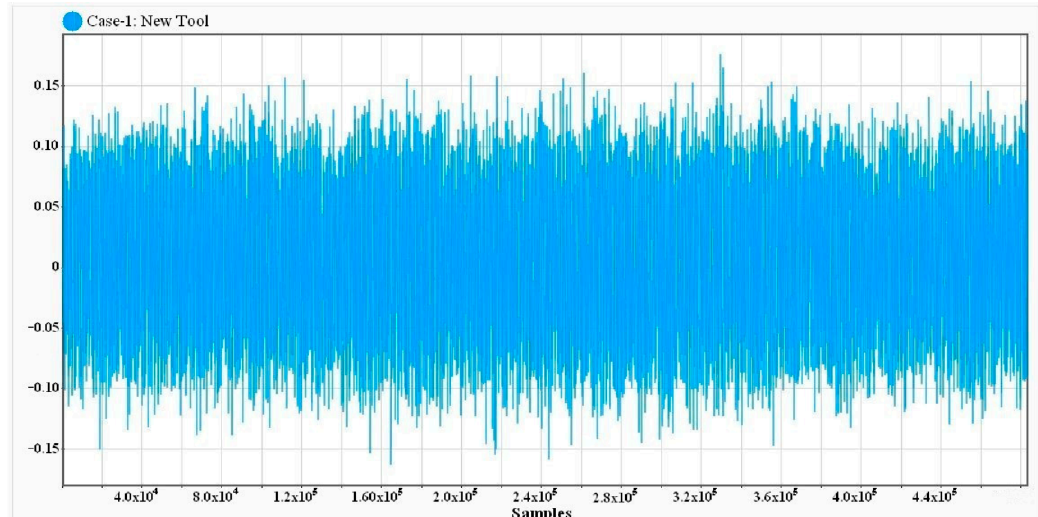
Figure 12. Plot of raw acoustic emission (AE) signal of 10 s duration for new carbide tool on aluminum work-piece (Case-1).